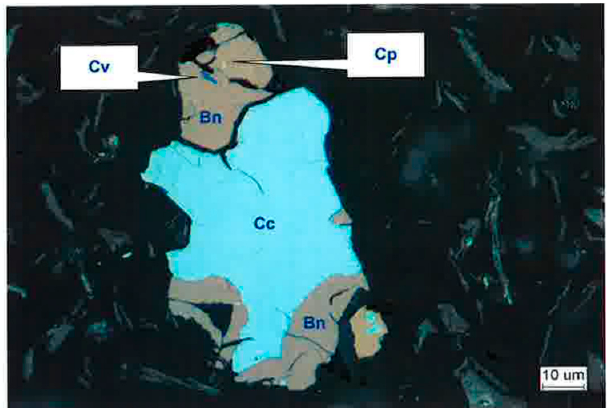
Figure 2. A photomicrograph of the copper sulphides present in the ore. Cc—chalcocite; Bn—bornite; Cp—chalcopyrite; and Cv—covellite.